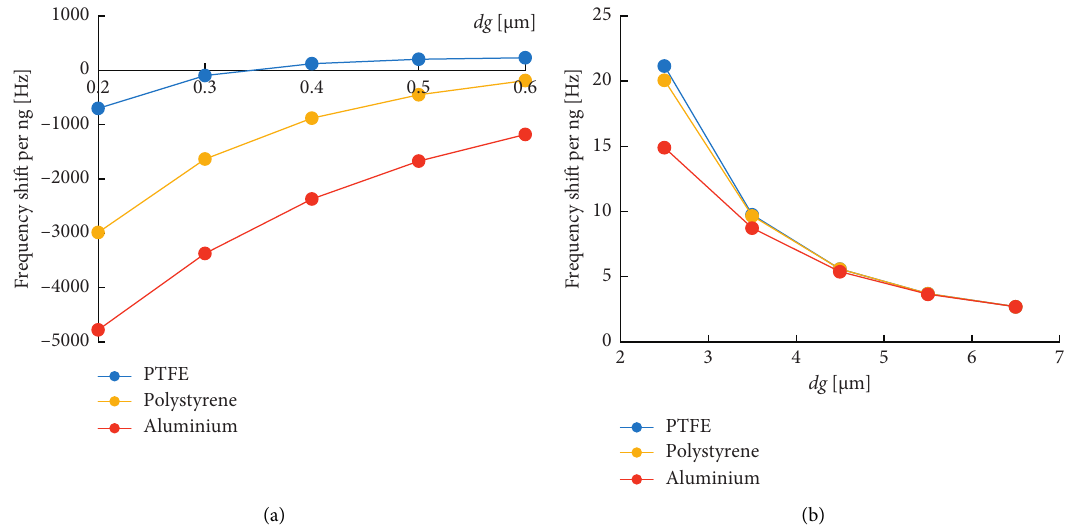
Figure 4: SAW Sensitivity vs. geometric mass mean diameter d � 2.5 ∼ 6.5 μ m and σ d g